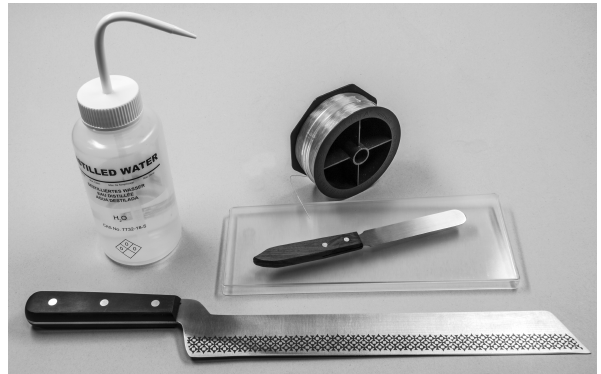
Figure 4. Equipment used for the preparation of sediment slabs for X-ray imaging comprise fishing line, distilled water, cheese knife, spatula and special Plexiglas lids for support of the sediment slab. Lids used for preparation measure 25cm × 10cm × 1cm (Bens- berger Kunststoffwerk Lappe GmbH). Lay-flat tubing and sealing device (not shown) are used to protect the sample from drying.